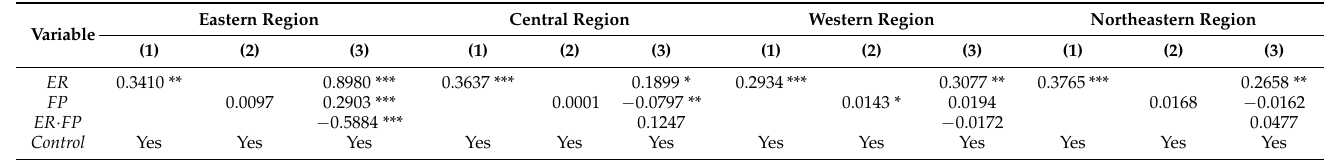
Table 4. Regression results by different economic regions.